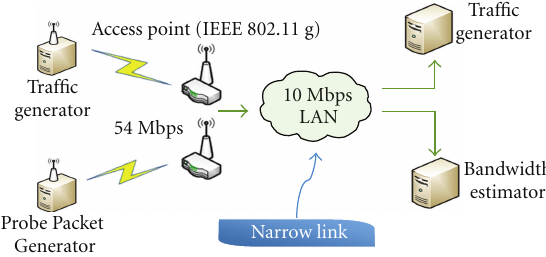
Figure 5: 10Mbps single hop tight